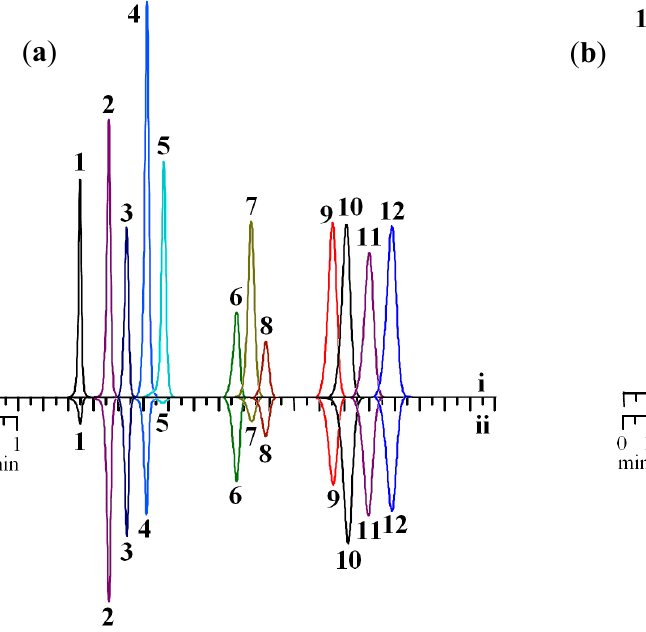
Figure 2. HPLC chromatograms of selected flavonoids standards (125 μ g/mL) before ( i ) and after prechromatographic reaction with Fe 2+ ions ( ii ). Samples: ( a ) flavones; ( b ) flavonols (on cut—chromatogram of flavonol glycosides). Detector λ —270